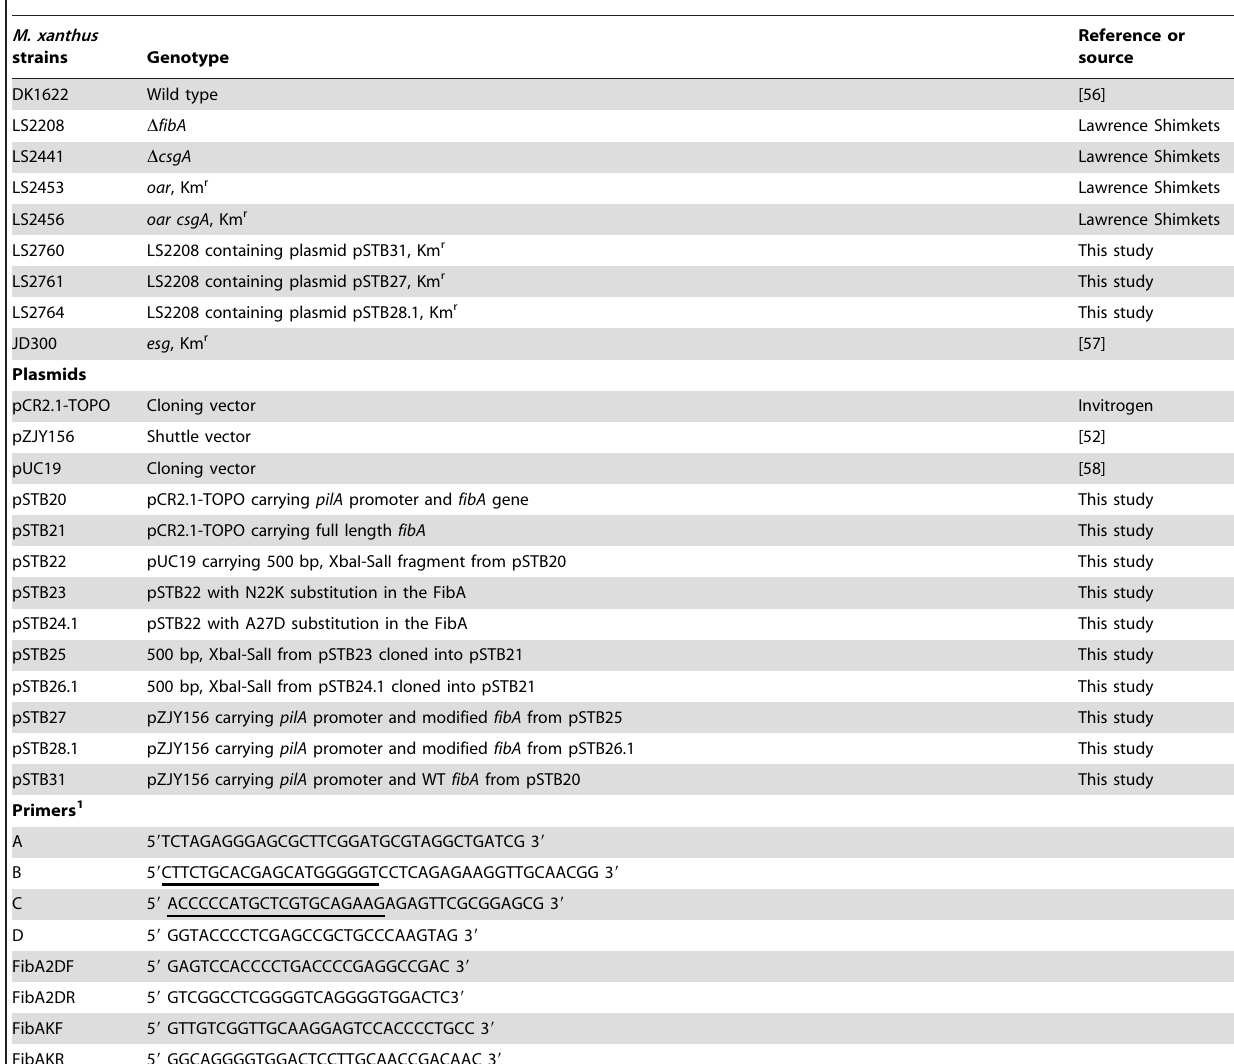
Table 6. Bacterial strains, plasmids and primers used in this